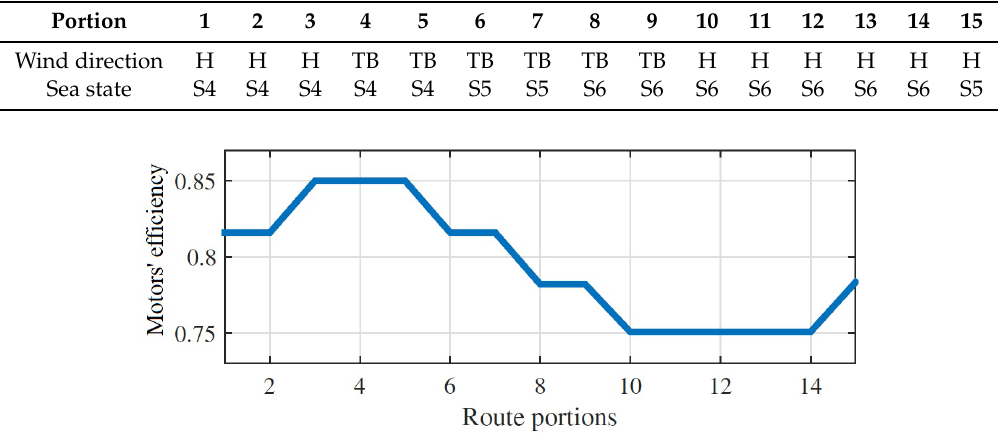
Figure 6. Impacts of weather condition on the motors’